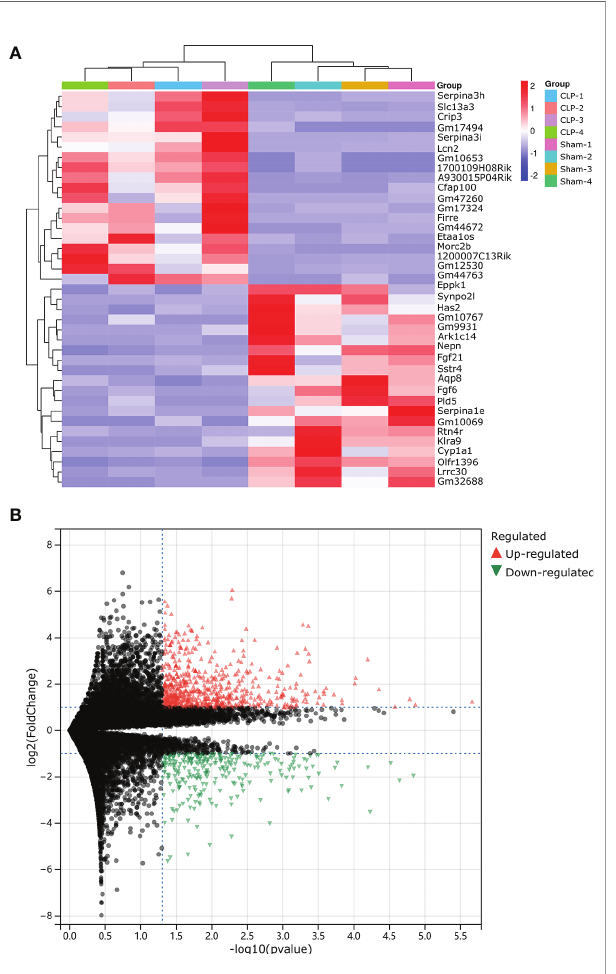
FIGURE 2 | Detection of differentially expressed mRNAs (DE-mRNAs) of mice myocardial tissue in the GSE179554 dataset. (A) An expression heatmap corresponding to the expression pro fi le of mRNAs in the mice myocardial tissue. (B) A volcano plot corresponding to the expression pro fi le of mRNAs in the mice myocardial tissue. The red plots represent upregulated genes, the black plots represent nonsigni fi cant genes, and the green plots represent downregulated